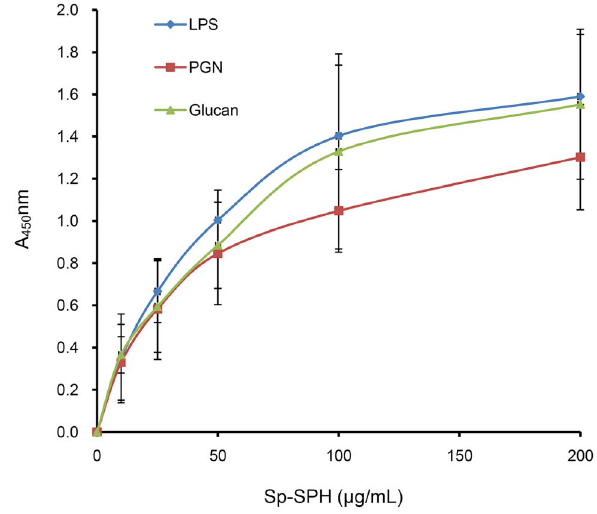
Figure 3. Analysis of the binding affinity between recombinant Sp-SPH protein and the bacterial or fungal associated mole- cules. The binding affinity of Sp-SPH protein to LPS, PGN or b -1, 3- glucan was tested by ELISA. Absorbance of each well was measured at 450 nm with a Multifunctional microplate reader (GENios). The binding parameters, apparent dissociation constant Kd, and the maximum binding (Amax), were determined by non-linearly fitting as A = Amax [L]/(Kd + [L]). Diamond:lipopolysaccharide (LPS); Square: peptidoglycan (PGN); Triangle: b -1, 3-glucan. The data were representative of the average value of four repeated experiments. Bars indicated mean 6 S.E. ( n =4).